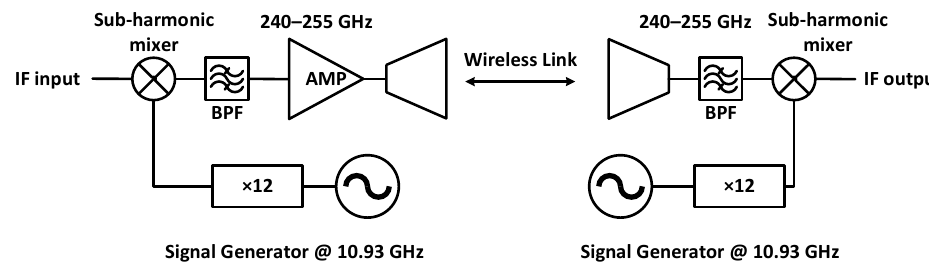
Figure 6. Schematic block diagram of the THz front-end modules.